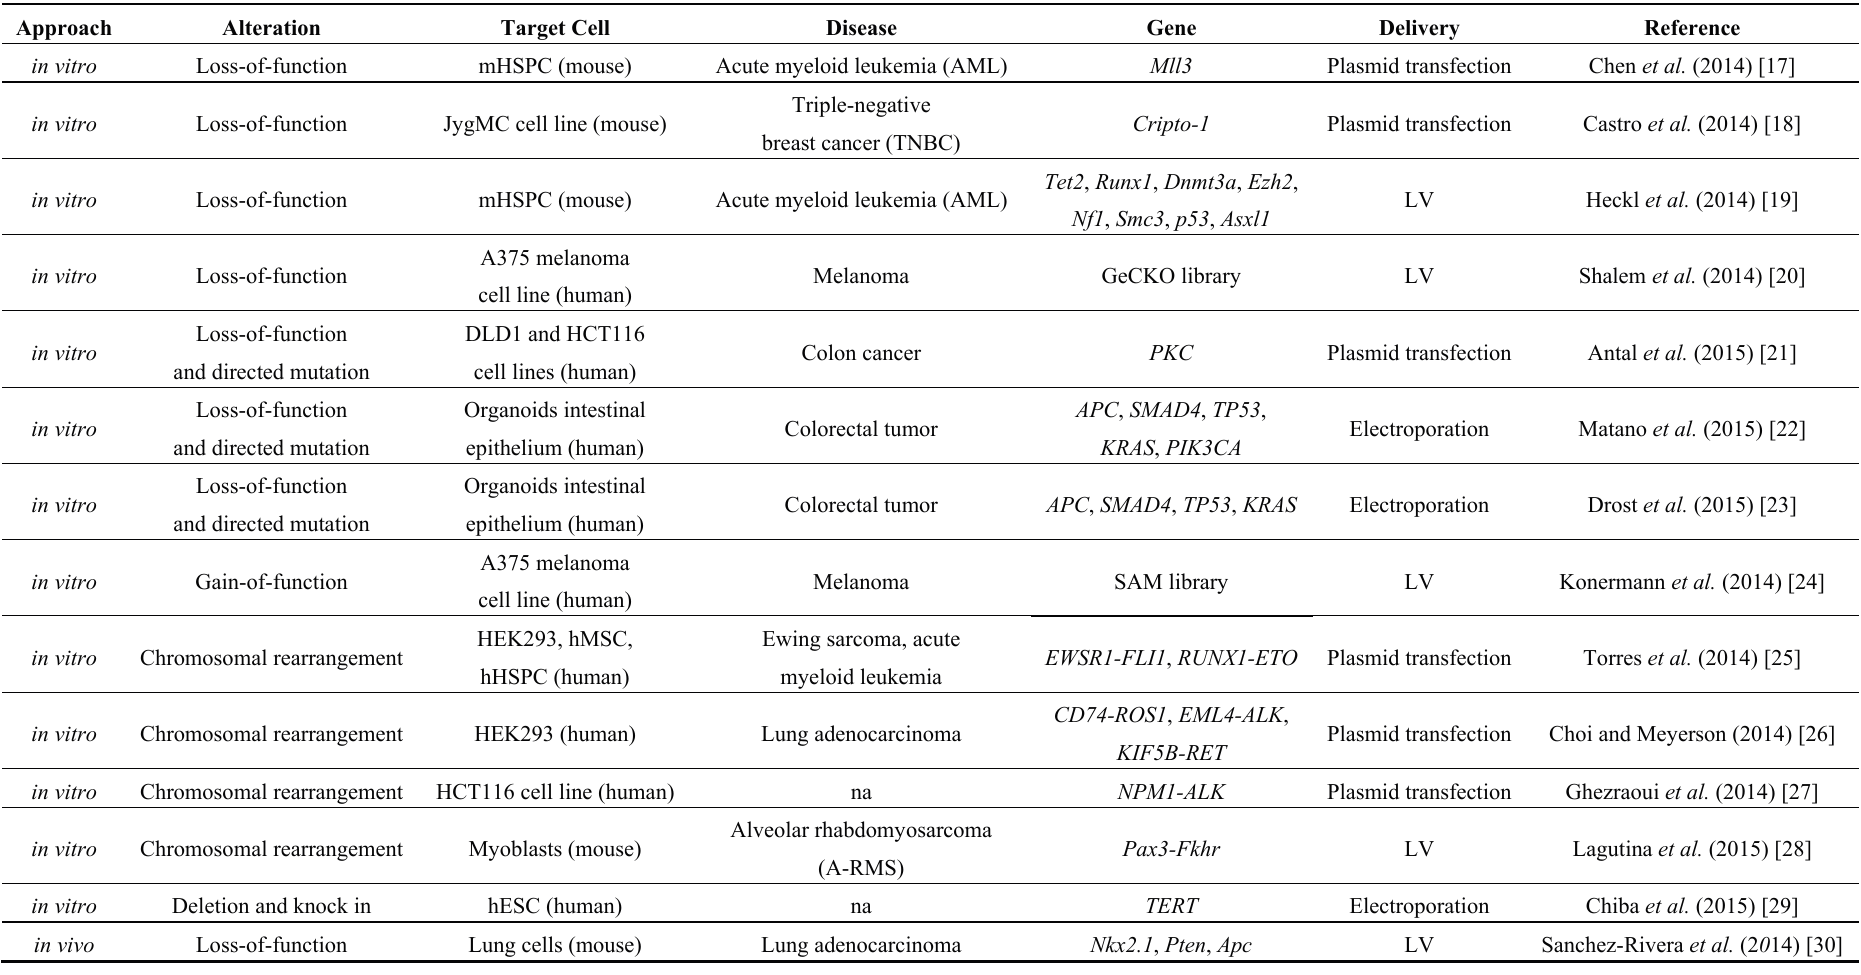
Table 1. Overview of the use of the CRISPR-Cas9 system in the context of cancer modelling. HSPC, hematopoietic stem progenitor